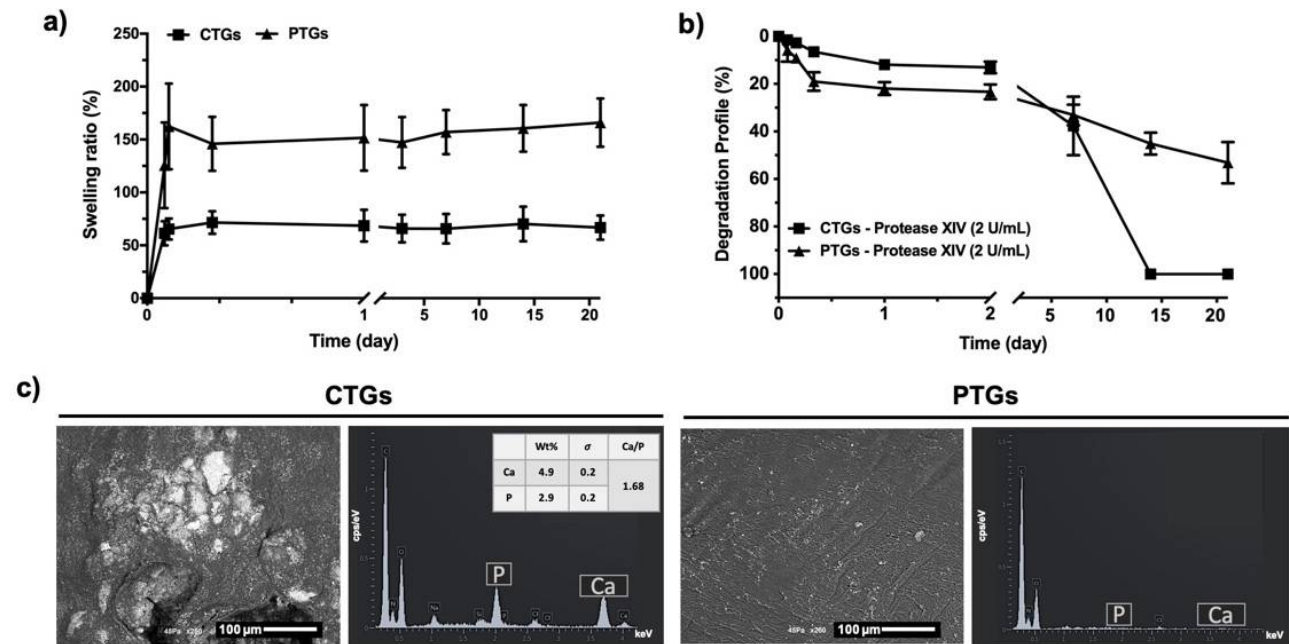
Figure 4. Swelling ratio, degradation profile and in vitro bioactivity. ( a ) Water uptake profile and ( b ) weight loss of the CTGs and PTGs immersed in PBS solution and protease XIV (2 U/mL) solution, respectively, for a period of 21 days (wt.%). ( c ) Representative SEM micrographs and EDS elemental analysis of the CTGs and PTGs after 7 days of immersion in SBF solution. σ stands for standard deviation.